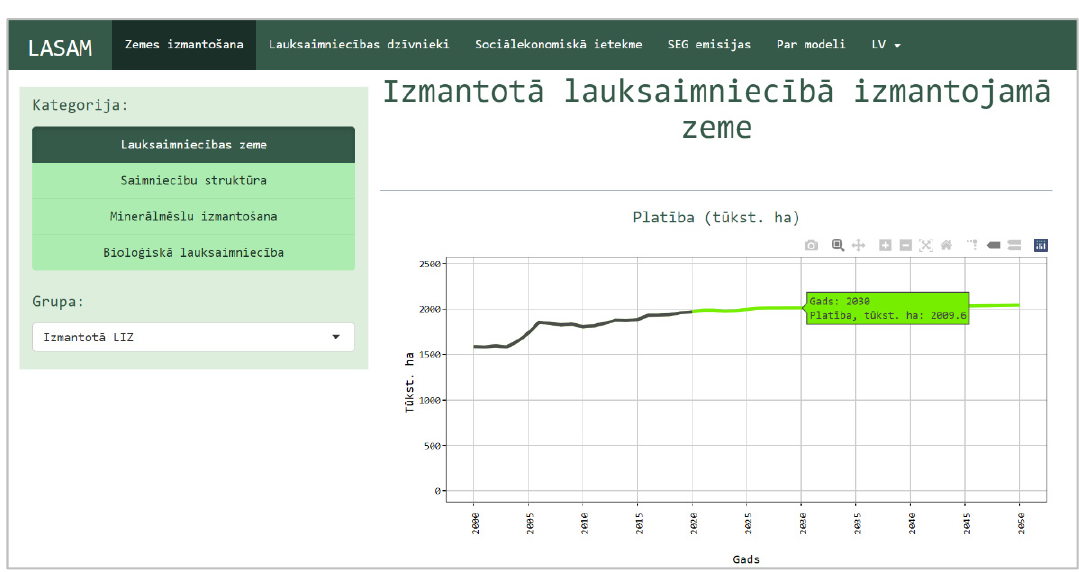
Figure 3. Publicly available LASAM model, in Latvian (example).